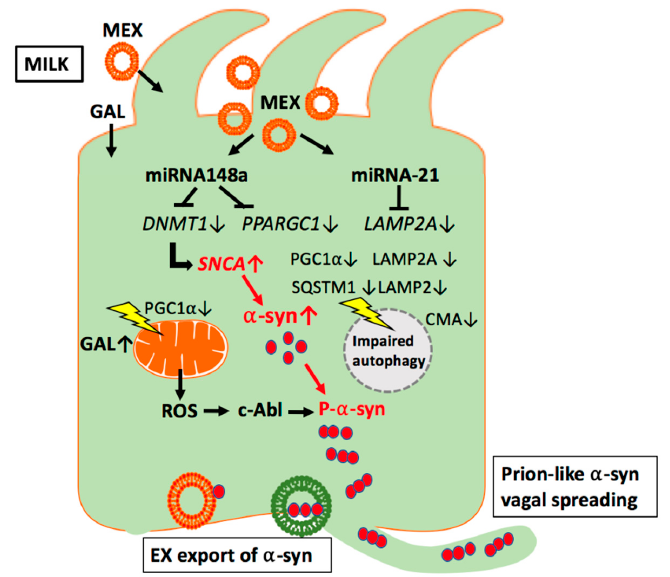
Figure 2. Working model of milk exosome (MEX) miRNA-mediated suppression of autophagy and mitochondrial function in enteroendocrine cells. MEX miRNA-148a may inhibit autophagy and mitochondrial function via suppression of peroxisome proliferator-activated receptor γ coactivator 1 α (PGC1 α ). In addition, MEX miRNA-21 may inhibit chaperone-mediated autophagy (CMA) via suppression of lysosome-associated membrane protein 2A (LAMP2A). Increased release of reactive oxygen species (ROS) via miRNA-148a- and galactose (GAL)-mediated impairment of mitochondrial function may activate the ROS-sensitive kinase c-Abl, which phosphorylates α -syn promoting its aggregation. Excessive α -syn oligomers are preferentially excreted by exosomal release and spread either via the vagal nerve route or systemic circulation.